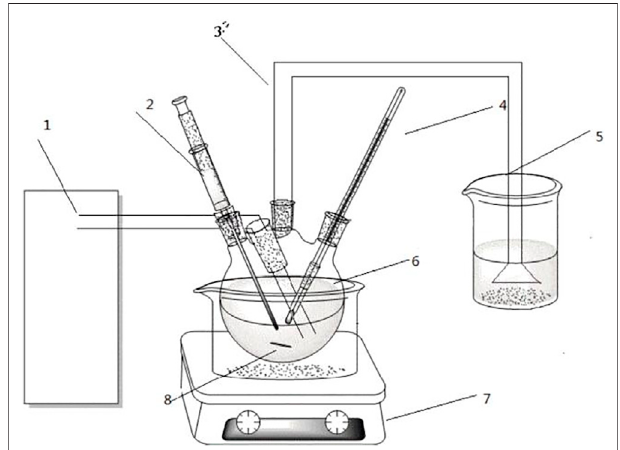
FIGURE 1 | Diagram of experimental devices. 1-Ozone generator, 2- colloidal sampler, 3-thermometer, 4-exhaust pipe, 5-tail gas recovery cup, 6- four-necked fl ask, 7-magnetic stirring heater, 8-stirring